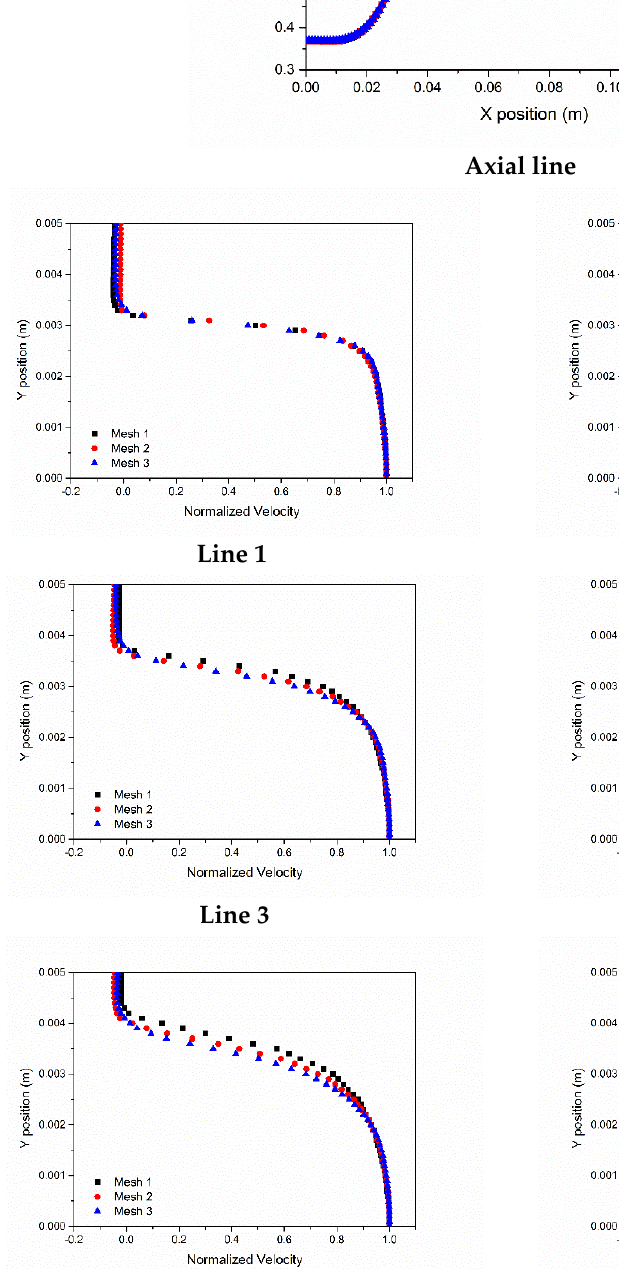
Figure 10. Average streamwise velocity profiles.